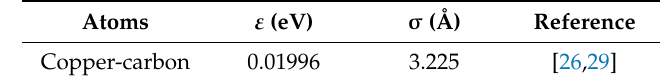
Table 1. Parameters of the LJ potential for the interactions between copper and carbon atoms.